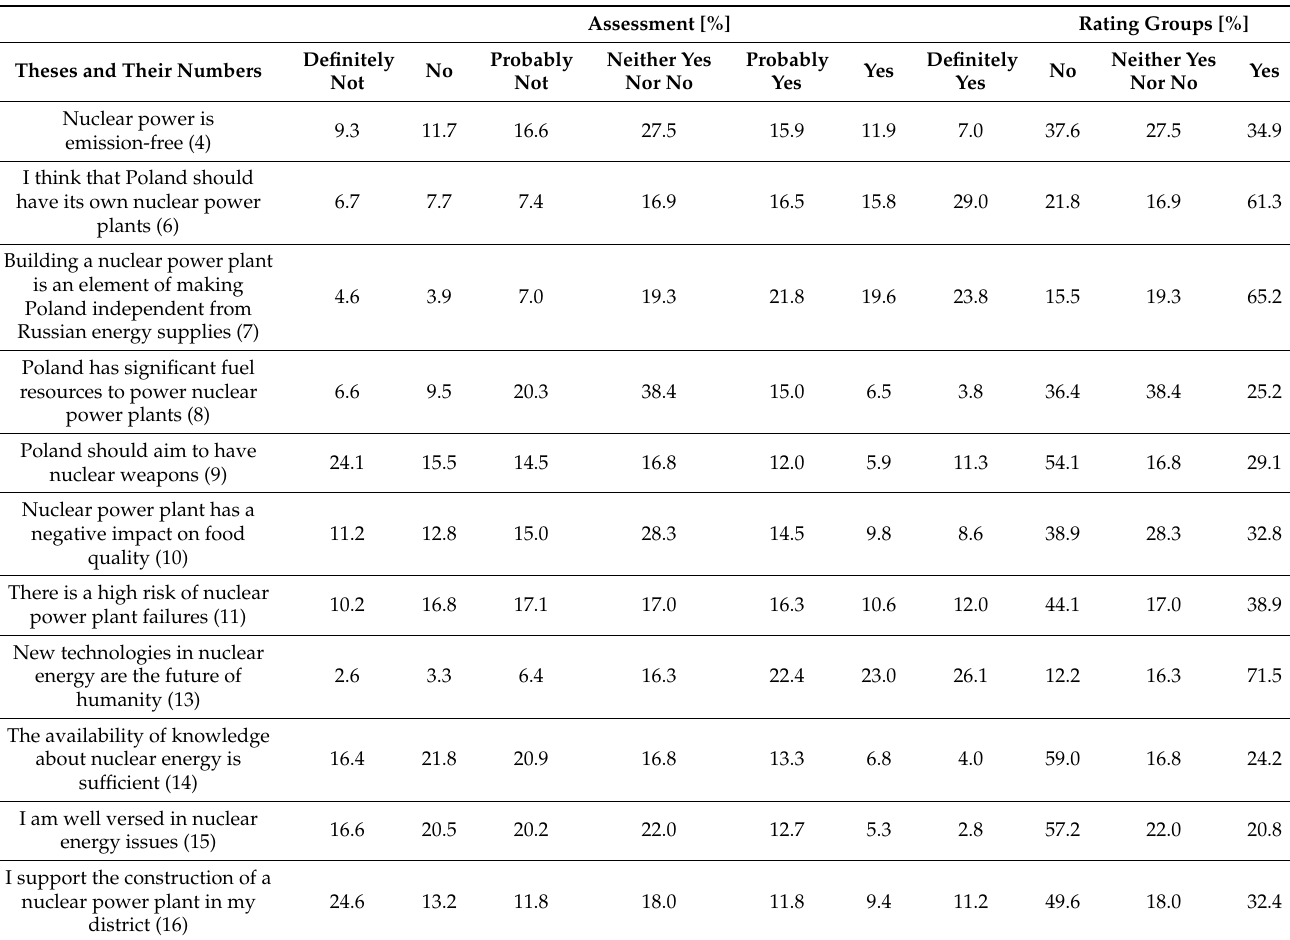
Table 6. Assessment structure of statements representing issues related to nuclear power using a seven-point bipolar scale and a group of assessments according to the direction of assessment (own